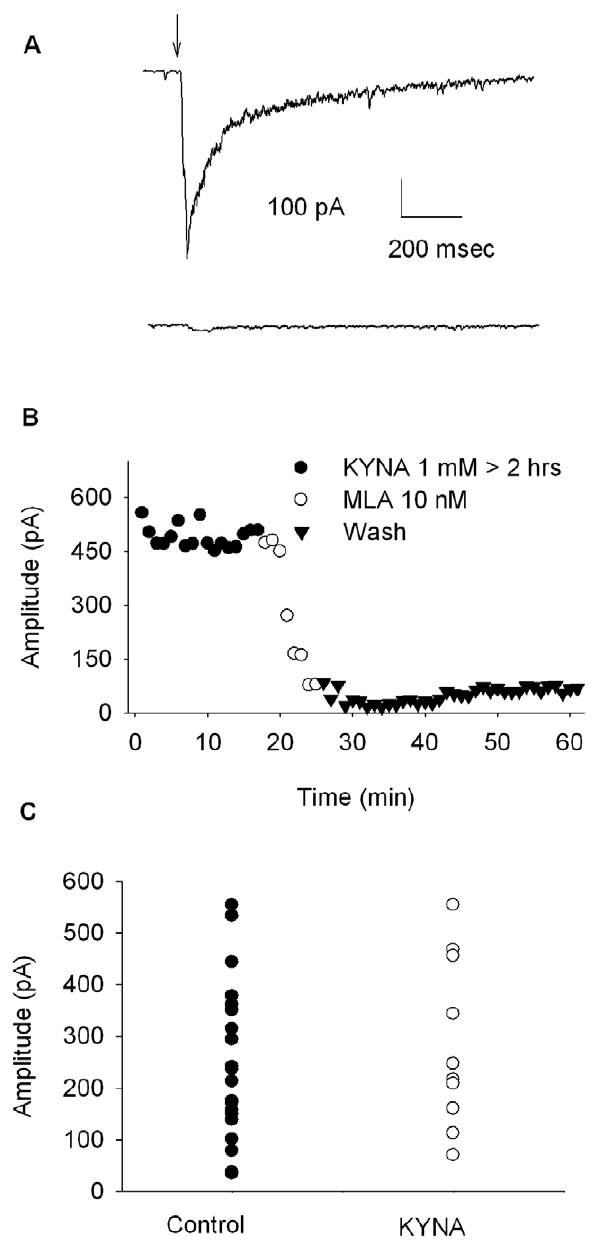
Figure 4. Effects of long term exposure to KYNA on pressure- applied choline-evoked a 7* currents. In these experiments, slices were prepared, stored and recorded in the presence of 1 mM KYNA (at least 90 min exposure). Panel A shows representative traces for a baseline choline-evoked a 7* current after 2 hrs exposure to KYNA (top trace) and after 5 min exposure to MLA (10 nM, bottom trace). Panel B shows the time course for this experiment. Panel C shows the distributions for control choline-evoked a 7* currents (n=20) and choline-evoked a 7* currents after at least 90 min exposure to 1 mM KYNA (n=10). Each point represents the average of 5–10 events, the error bars were omitted for clarity. There was no significant difference between groups (t=0.5899, df=28, p=0.56, unpaired